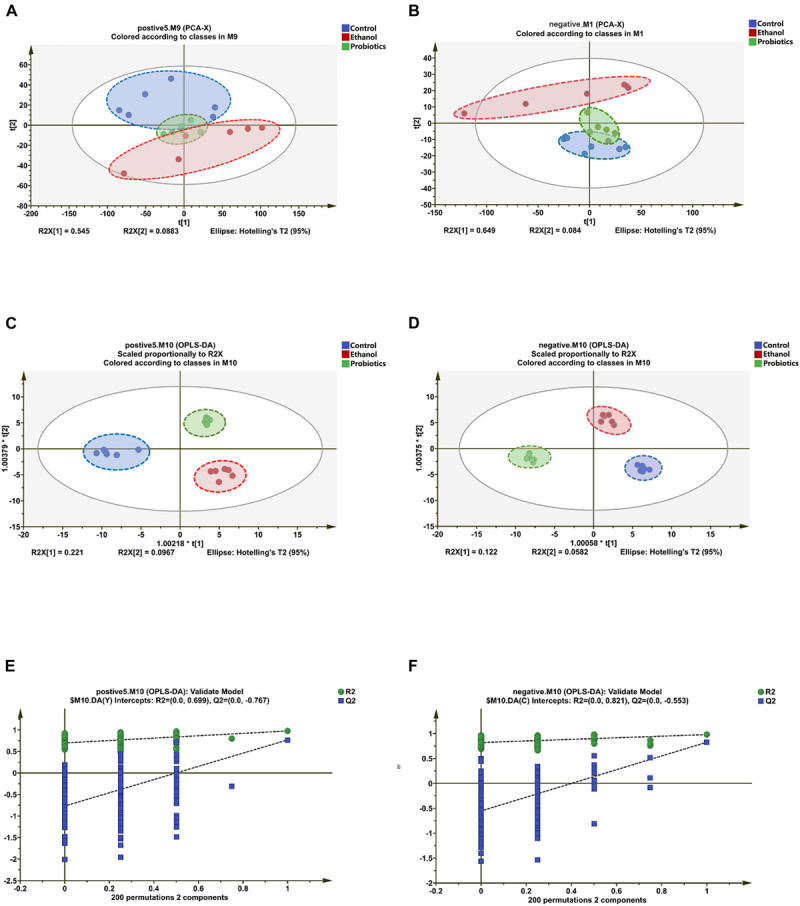
Differentiation of the liver metabolic profiles of the control group, ethanol group, and the probiotics group. (A,B) PCA score plots based on the liver metabolic profiles of the three groups in the positive and negative modes: ESI + : R2 = 0.545, ESI-: R2 = 0.649. (C,D) OPLS-DA score plots of the three groups in the positive and negative modes: ESI + : R2X = 0.735, R2Y = 0.995, Q2 = 0.728; ESI-: R2X = 0.711, R2Y = 0.974, Q2 = 0.792. (E,F) Permutation test of the OPLS-DA model: ESI + : the intercepts of R2 = 0.699 and Q2 = -0.767, ESI-: the intercepts of R2 = 0.821 and Q2 = −0.553.